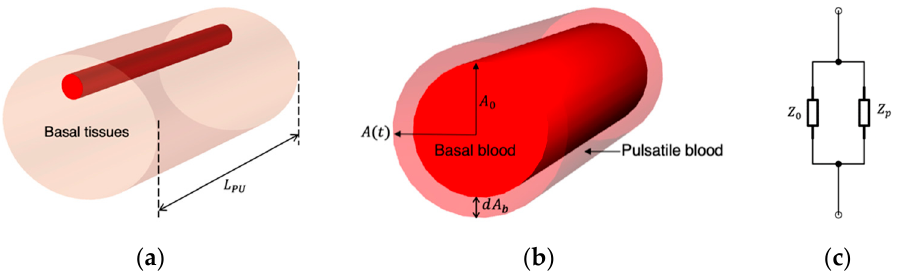
Figure 4. The relationship between the impedance changes and the artery diameter change: ( a ) measured segment of the human wrist; ( b ) cross-sectional area change of the artery; ( c ) equivalent circuit of the pulsatile blood.